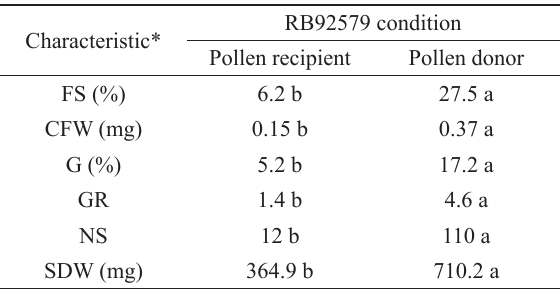
Percentage of fertile spikelets (FS), caryopsis fresh weight (CFW), germination (G), index of germination rate (GR), number of normal seedlings per gram of fuzz (NS), and seedling dry weight (SDW) from hybridizations involving RB92579 sugarcane cultivar as pollen recipient and pollen